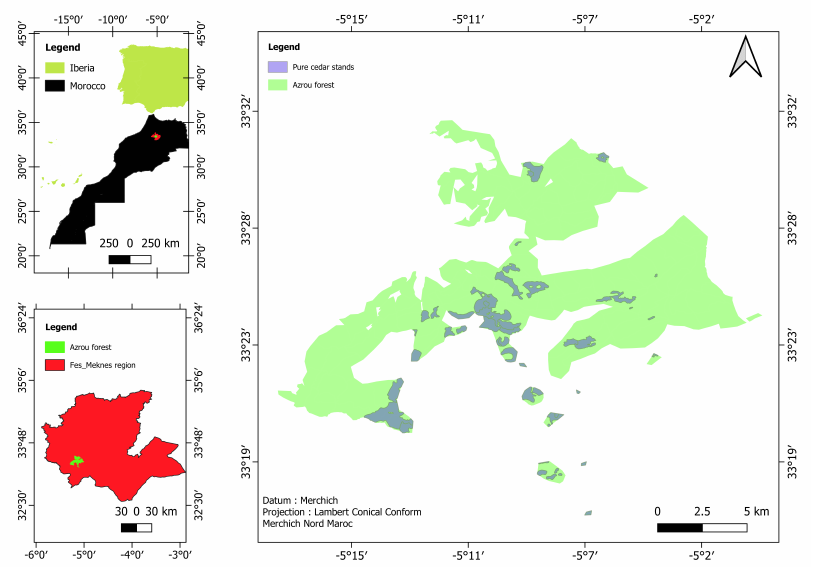
Figure 1. Map of the administrative situation of the Azrou forest and the location of pure cedar stands in this